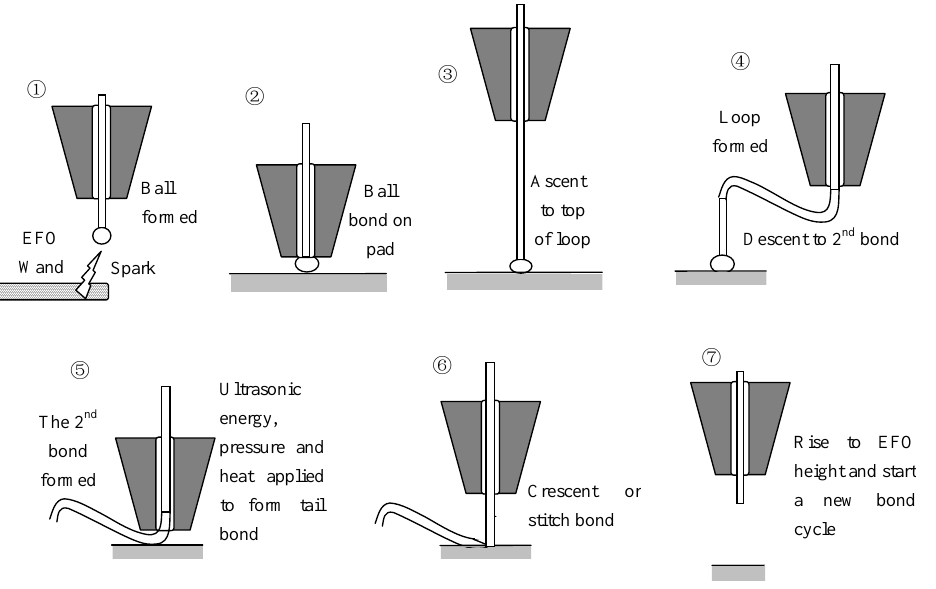
Figure 1. Simplified procedure for making a ball-stitch wire interconnection with a